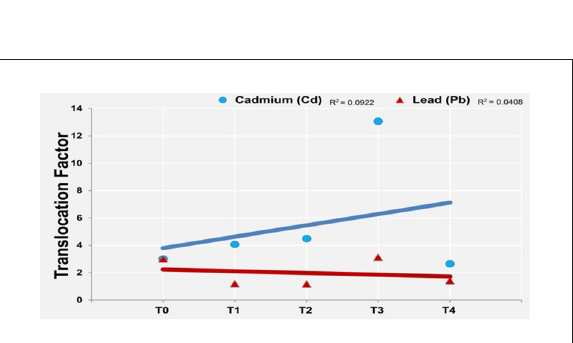
FIGURE4 Linear correlation between translocation factors of Pb and Cd in P. hysterophorus